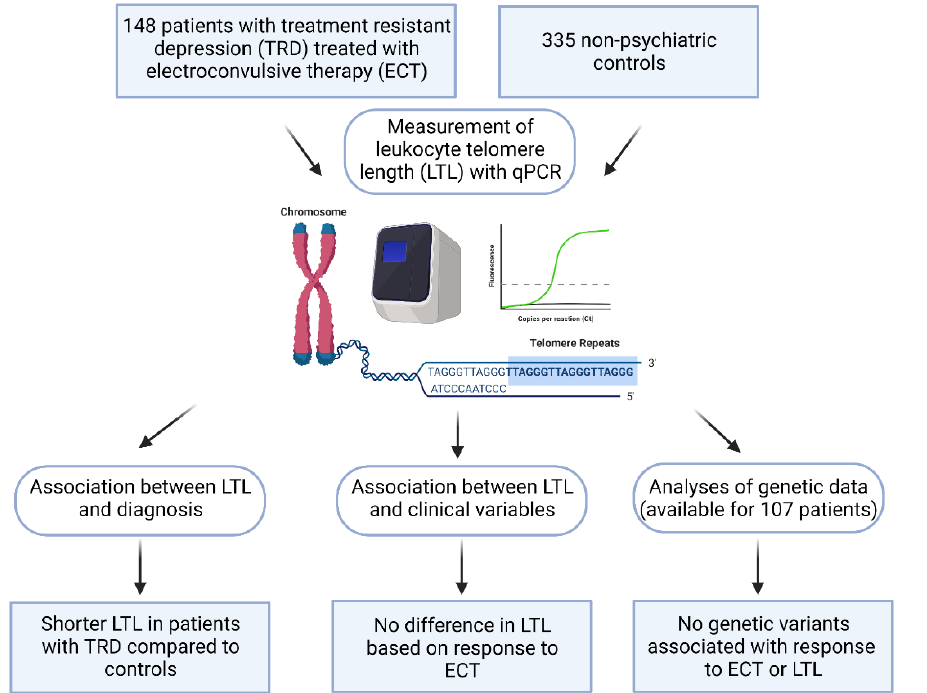
Figure 2. Negative correlation between LTL and age in the sample including 148 patients with TRD and 335 controls. Table 1. Demographic characteristics of the sample.